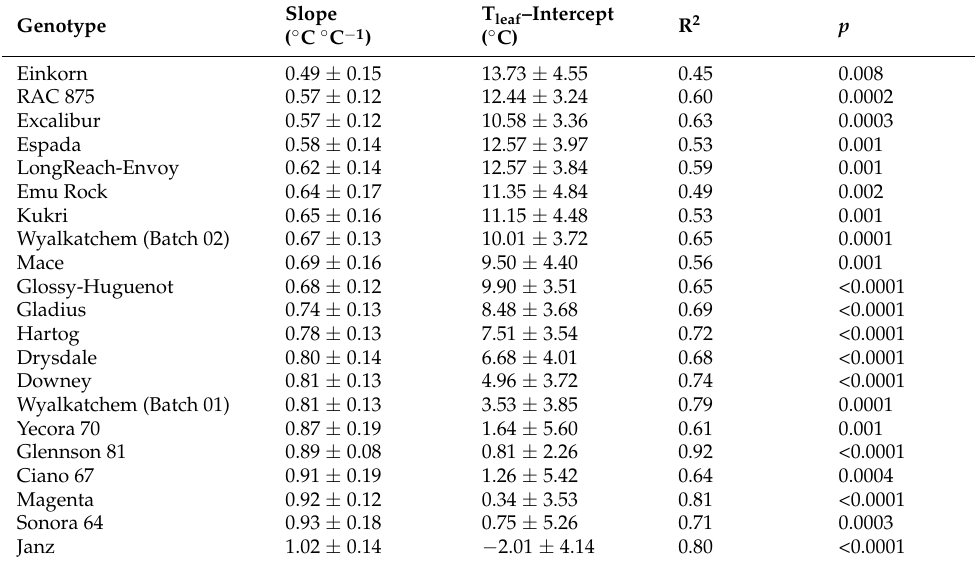
Table 5. Parameters of linear regression models for the relationship between leaf temperature (T leaf ) and air temperature (T air ) in 20 wheat genotypes. Data are means ± SEM for the best-fit values and the goodness of fits of the